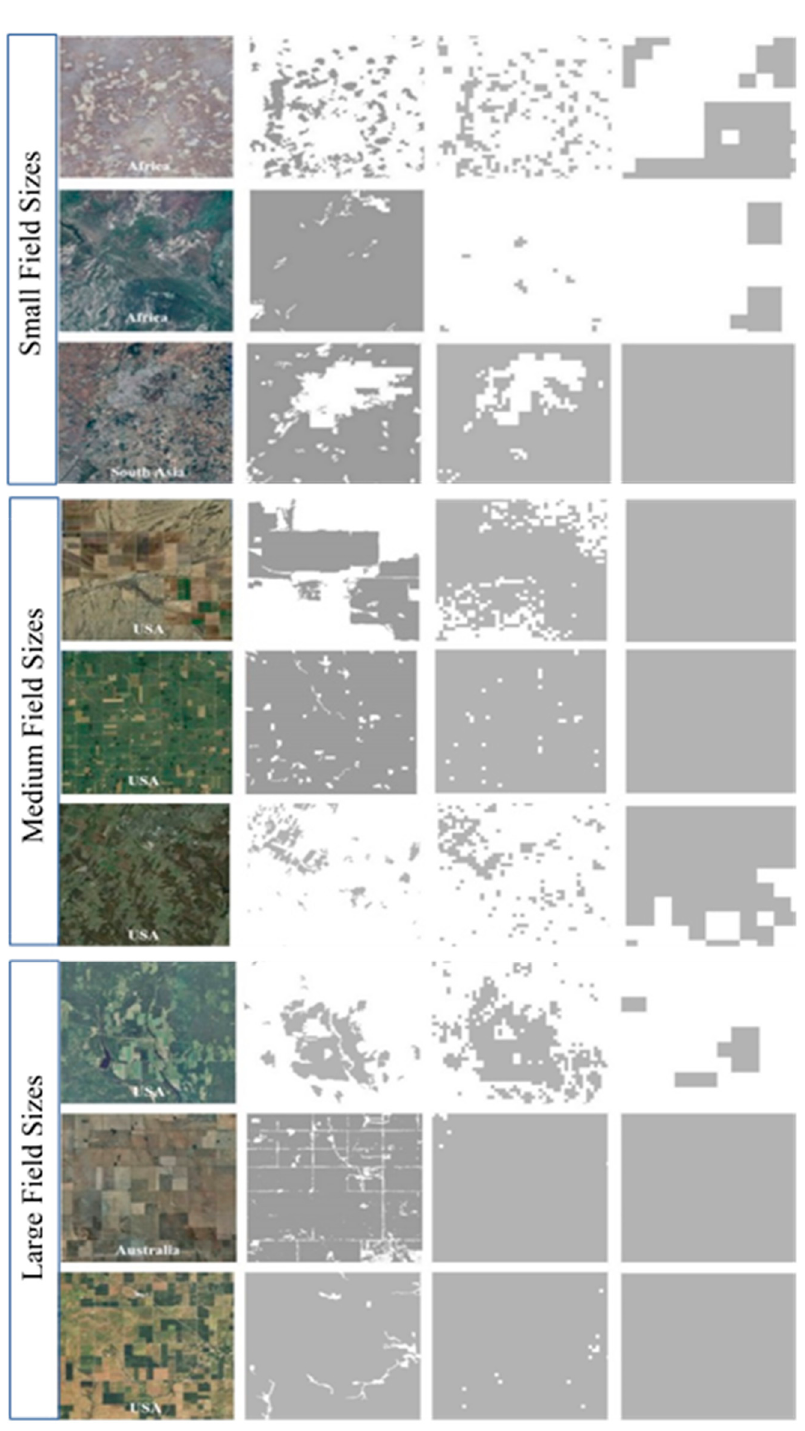
Figure 9. Visual comparison of the three different GFSAD cropland extent maps with high-resolution images acquired for small, medium, and large field sizes at random study sites around the entire world. The gray area represents the crops.